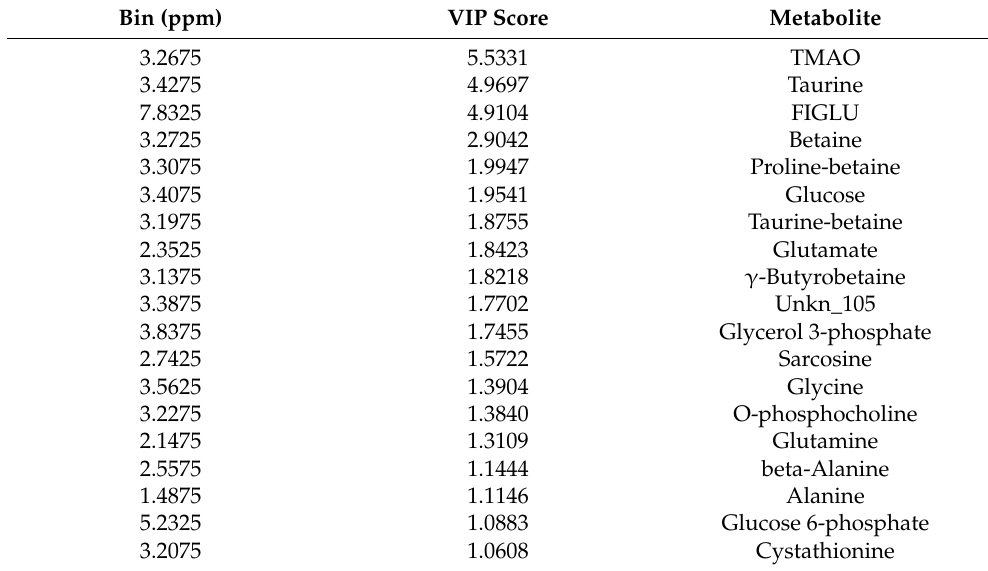
Table 1. VIP scores for the 19 most discriminating metabolites among the dietary treatments identified from PLS-DA of 1 H NMR spectra of red drum liver extracts.